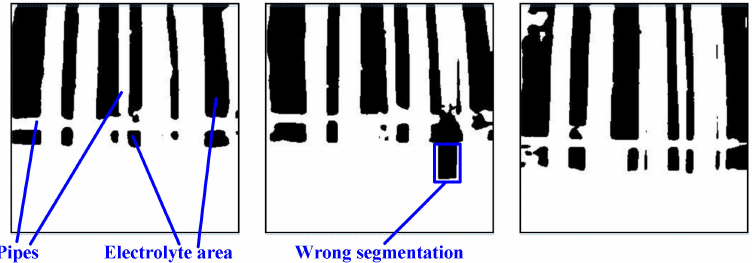
Figure 5. The results of copper rod segmentation based on the Otsu